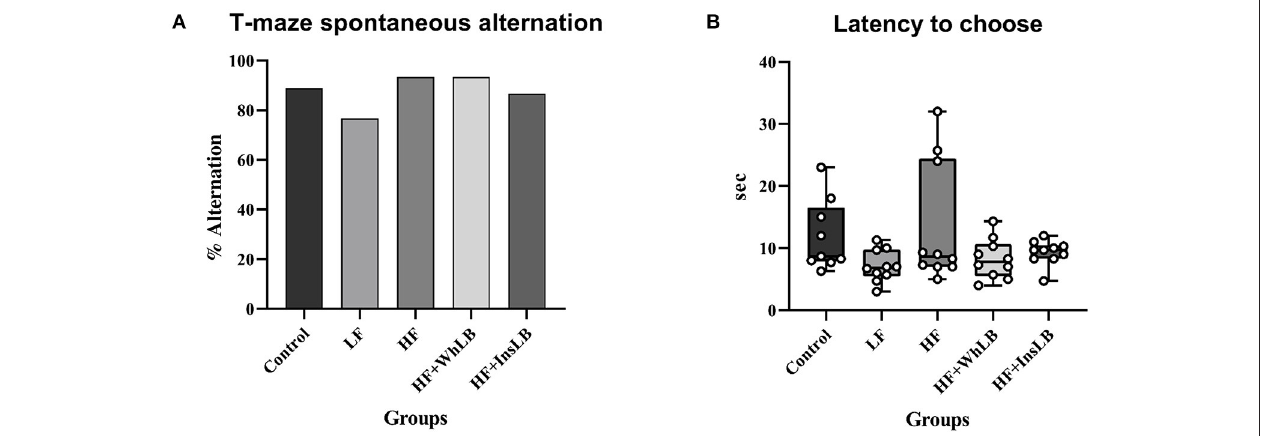
FIGURE 2 | T-maze spontaneous alternation test. (A) The percentage of alternation. (B) Latency to choose the arm in the second trial. Fisher’s exact test was used for categorical data analysis. Continuous data distribution is expressed with the aid of the box and whisker plots: the median is shown by the horizontal line, the box is limited by 25th and 75th percentiles (interquartile range, IQR), while the whiskers represent the full range of data ( n = 9–10/group). Comparisons among groups were performed with the non-parametric Kruskal-Wallis test, followed by Dunn’s post hoc test.